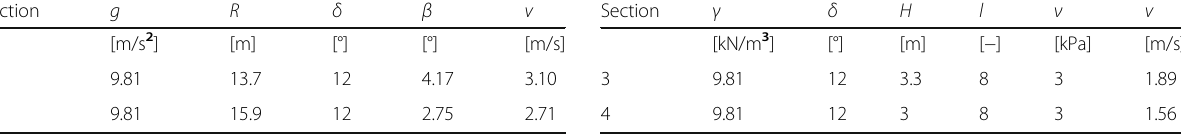
Table 2 Velocity values of the flow obtained according to the Johnson & Rondine (1984) formula Section